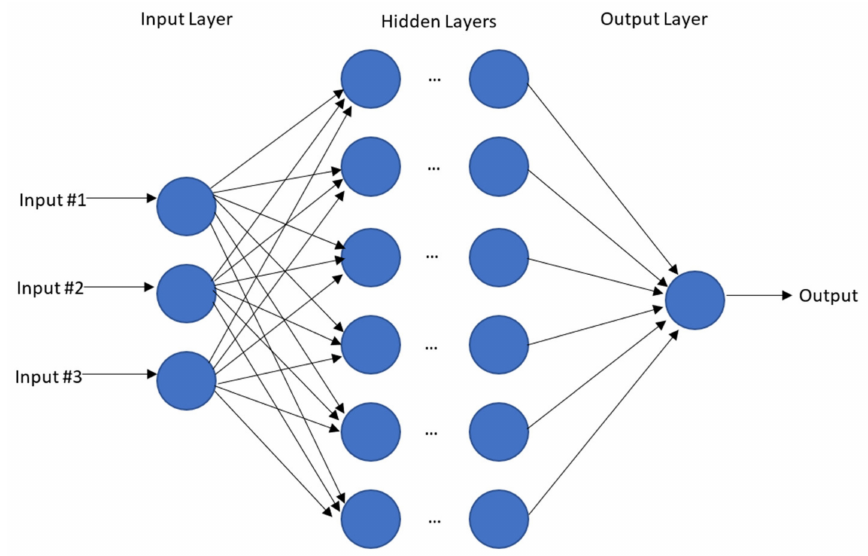
Figure 21. Neural network with many hidden